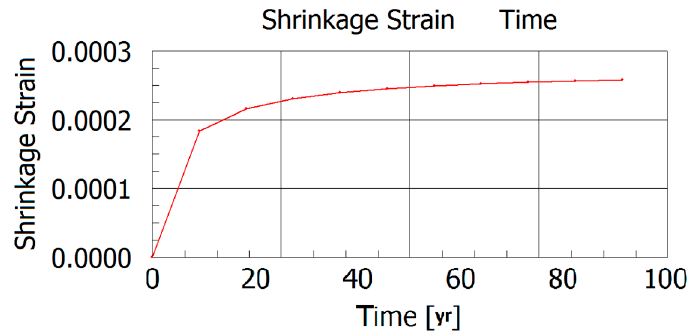
Figure 8. Shrinkage Strain Versus Time.